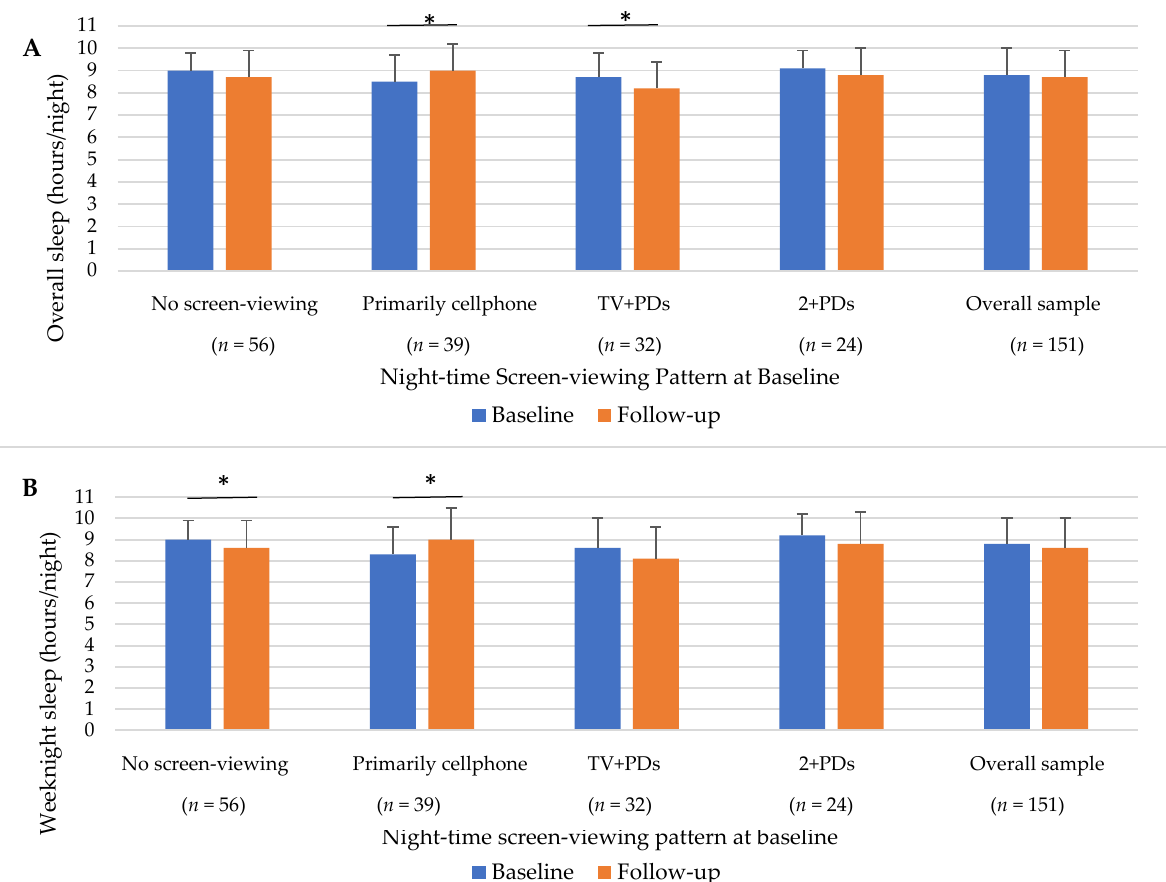
Figure 2. Changes in overall and weeknight sleep by night-time screen-viewing pattern. ( A ) Overall Sleep ; ( B ) Weeknight Sleep ; values presented are unadjusted means and standard deviations; * significant difference between baseline and follow-up using paired t-test within group.